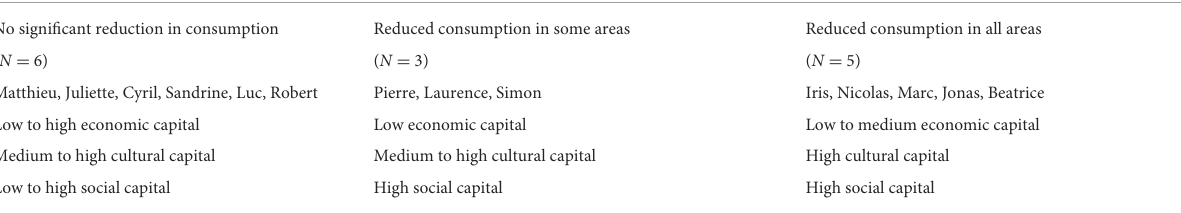
TABLE 1 Patterns of sustainable consumption in couples with reduced working hours. Group 1: Low sustainable consumption Group 2: Moderate sustainable consumption Group 3: Strong sustainable